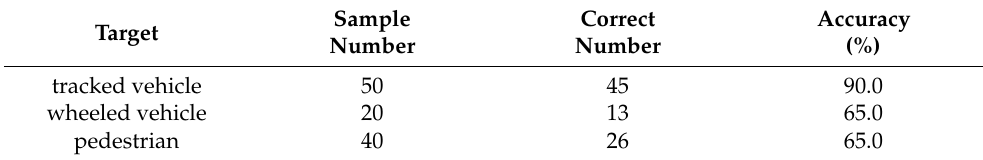
Table 5. Outdoor recognition